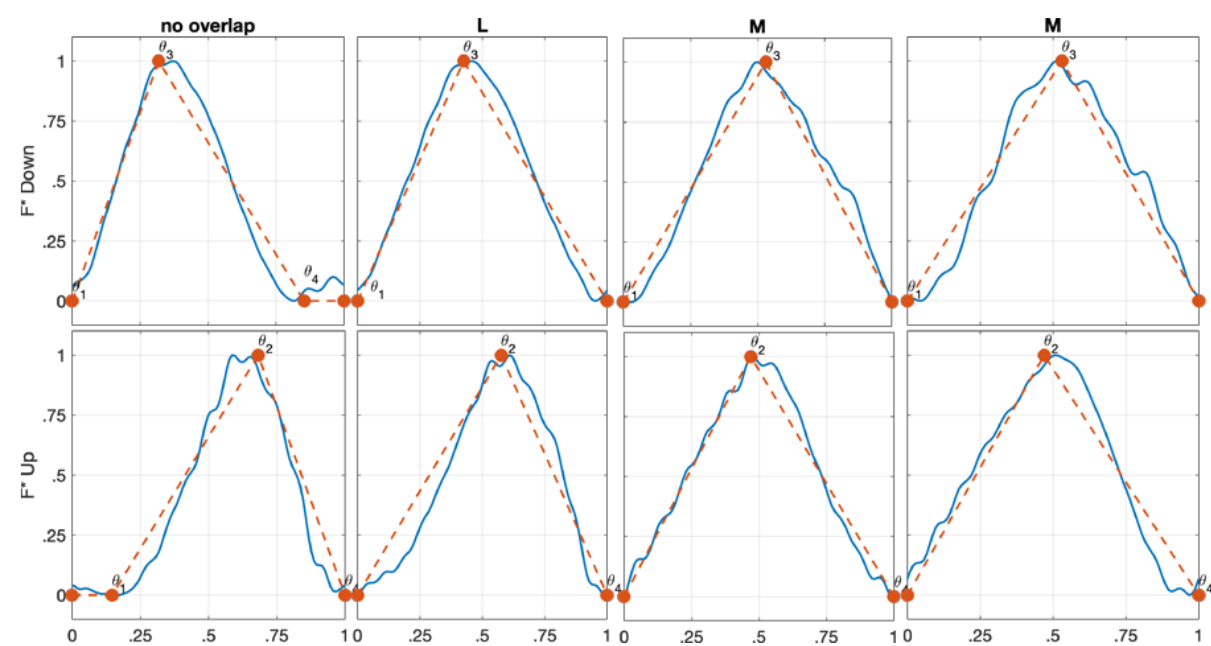
Figure 7. Type I normalized F shapes for tool 1 (tests 1 to 4 in down-milling; tests 5 to 8 in up-milling).